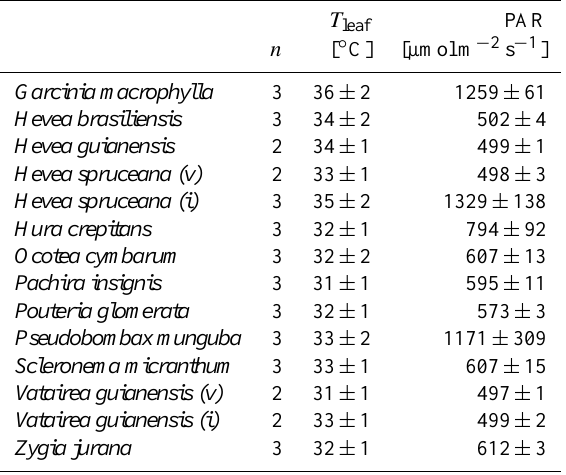
Table 3. Leaf temperature ( T leaf ) and photosynthetic active radia- tion (PAR) of tropical plants measured under semi-controlled con- ditions. Enclosure temperatures were not significantly different as compared to leaf temperatures with 1 ◦ C lower mean temperatures at most. Averages ± standard deviation of measurements with n tree individuals. Each replicate represents an average of data points measured every minute during one day measurement by a PAR < 300µmolm − 2 s − 1 (this PAR value was determined with light curves (data not shown) and represents the photosynthetic satura- tion point of all tropical